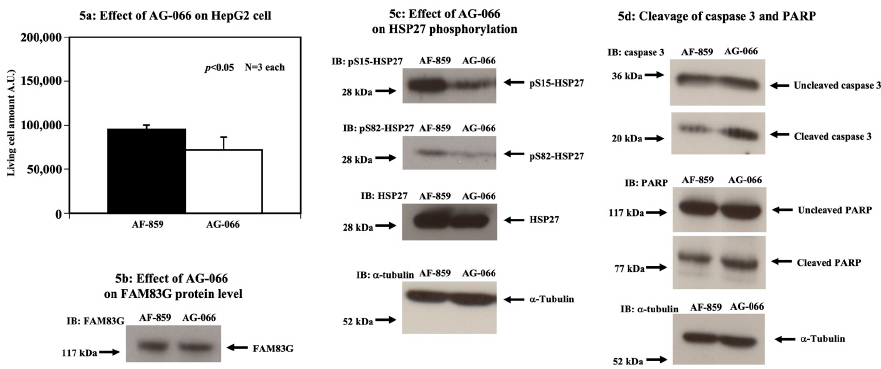
Figure 5. The FAM83G AG-066 peptide activates apoptosis through the reduction of HSP27 phosphorylation in HepG2 cells. ( a ) AG-066 reduces the live HepG2 cell number. The treatment of HepG2 cells with 54 μ M AG-066, containing an amino terminal antenna peptide allowing for specific entry into live cancer cells (right column), significantly reduced the number of live HepG2 cells relative to the effect of treatment with 54 μ M AF-859, which lacked an amino terminal antenna peptide (left column). The experiments were independently performed in triplicate. ( b ) AG-066 does not affect FAM83G protein levels. Immunoblots show that the peptides AF-859 and AG-066 had no effect on the endogenous FAM83G protein levels. The experiments were independently performed in triplicate. ( c ) Effect of AG-066 on HSP27 phosphorylation. Whole cell lysates of cells treated with either AF-859 (left lane) or AG-066 (right lane) were analyzed by immunoblotting (IB) with antibodies specific for anti-phospho-(S15) HSP27 (top panel) and anti-phospho-(S82) HSP27 (second panel down). HSP27 IB shows AG-066 had no effect on endogenous HSP27 protein levels relative to AF-859-treatment (third panel down). α -tubulin IB shows that sample loading was equivalent in all of the lanes (bottom panel). These data indicate that AG-066 treatment reduces both the S15 and S82 phosphorylation of HSP27 in HepG2 cells. The experiments were independently performed in triplicate. ( d ) AG-066 causes the apoptosis of HepG2 cells (cleavage of caspase 3 and PARP proteins). Cells treated with AG-066, but not AF-859, showed an increase in both caspase 3 and PARP protein cleavages. Top two panels: levels of cleaved and uncleaved caspase 3 proteins (arrow) following the treatment of HepG2 cells with AF-859 (left lane) and AG-066 (right lane). Third and fourth panels from the top: levels of cleaved and uncleaved PARP proteins (arrow) following the treatment of HepG2 cells with AF-859 (left lane) and AG-066 (right lane). Bottom panel: α -tubulin IB shows equivalent protein loading in each lane. The experiments were independently performed in triplicate.